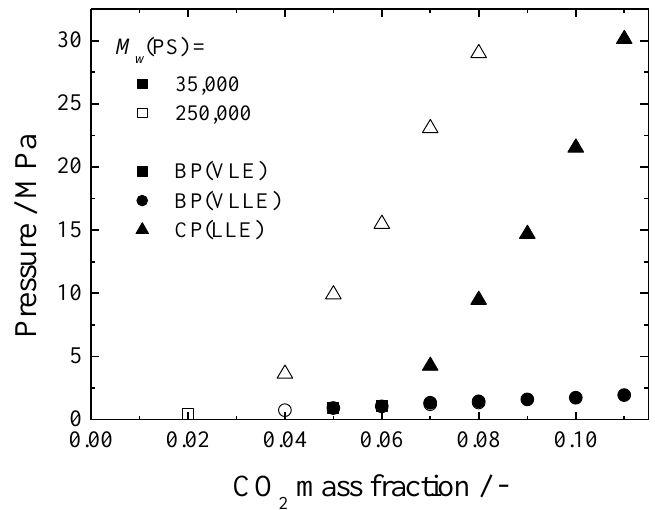
Figure 2. Effect of the polymer molecular weight on the phase behavior of a CO 2 /MTMS/PS ternary system (313.2 K, MTMS:PS = 9:1).